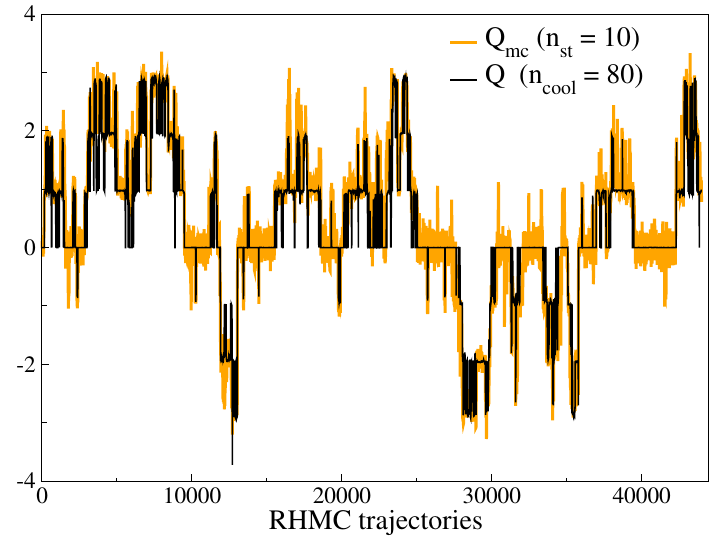
Figure 7 . Monte-Carlo history of the topological charges obtained after 80 cooling steps and after 10 stout-smearing steps (with (cid:26) st = 0 : 1), for the run on the 48 3 (cid:2) 16 lattice at (cid:12) = 4 : 592, adopting a bias potential as in eq. (2.12), with B = 11 and C = 2.